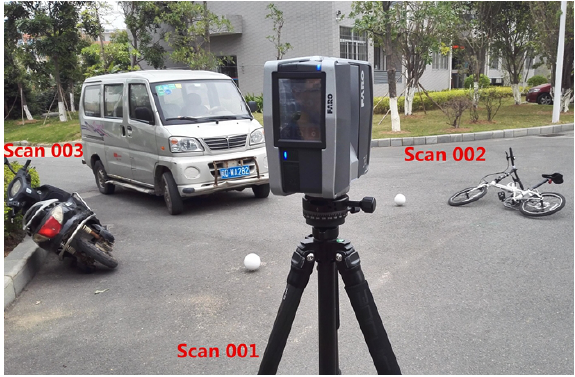
Figure 1. Scanner scans the scene of the